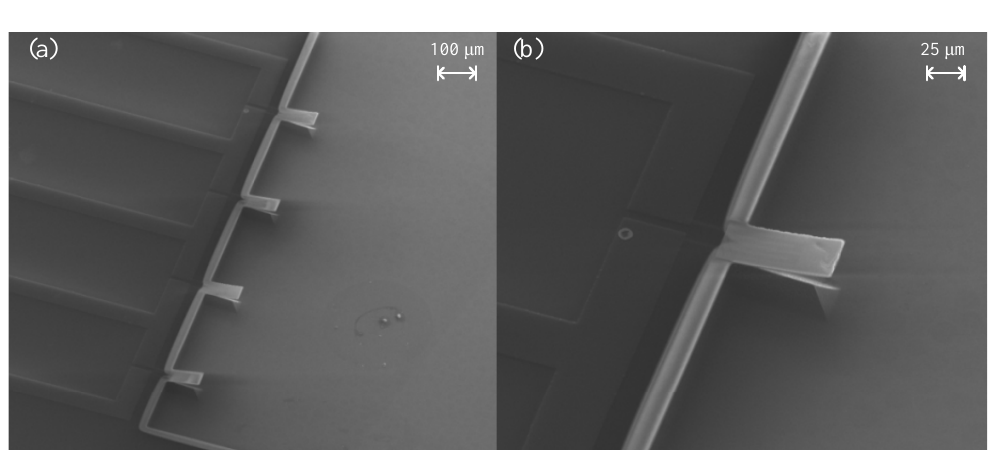
Figure 3. 3D measurement and observations images by laser confocal scanning microscope LEXT OLS5000 ( a , b ) are the top and 3D visions of a microcantilever. The height of free end is 77.587 µ m. ( c ) is the height scope of the microcantilever. The upper bend of the free end of the microcantilever is 36.122 µ m and the depth of reactive well is 40.534 µ m.